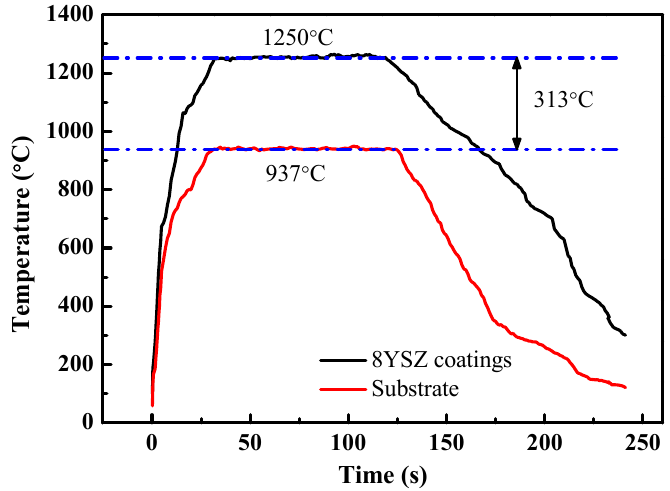
Table 5. Experimental parameters of environmental simulator test system.